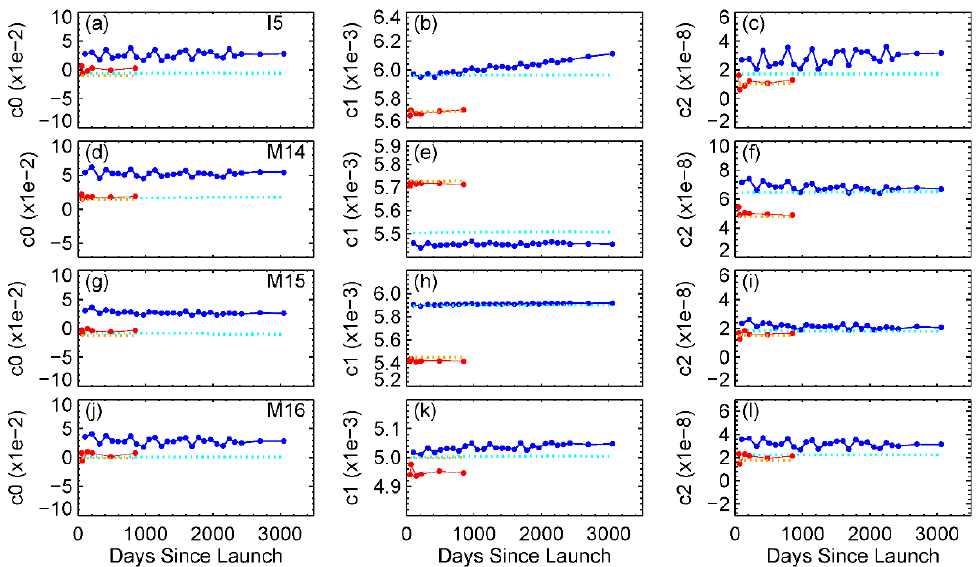
Figure 7. Comparison of WUCD derived LWIR band-averaged C-coefficients ( c 0 , c 1 and c 2 ) for NOAA-20 (red) and S-NPP (blue): ( a – c ) I5, ( d – f ) M14, ( g – i ) M15, ( j – l ) M16. Prelaunch C-coefficients are shown in dash lines (NOAA-20: orange color; S-NPP: cyan color).